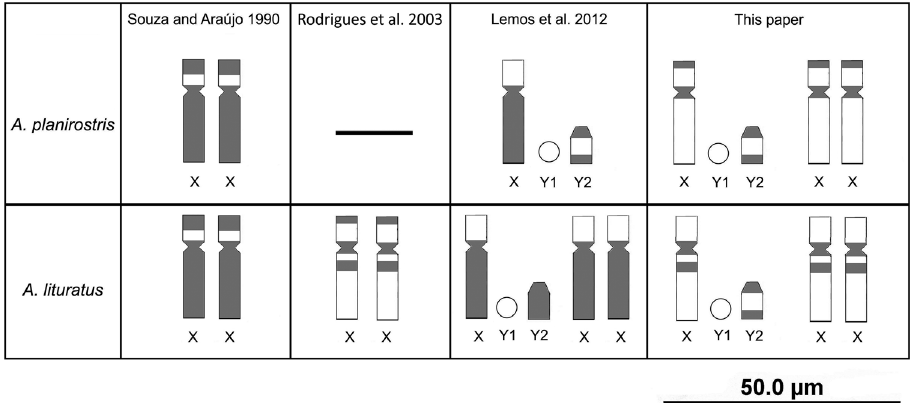
Figure 2. Schematic representation of A. planirostris and A. lituratus sex chromosomes showing C-band- ing variation reported in different studies. Gray shading corresponds to heterochromatin and the euchro- matic regions are depicted in white